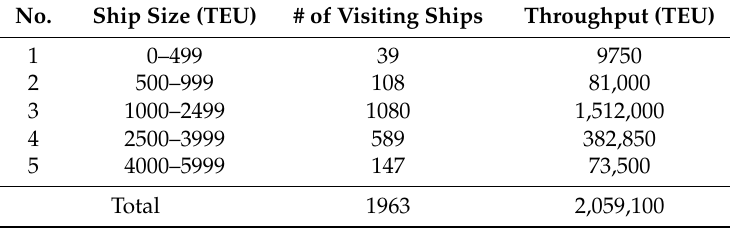
Table 1. Expected throughput pattern for the Port of Surabaya.